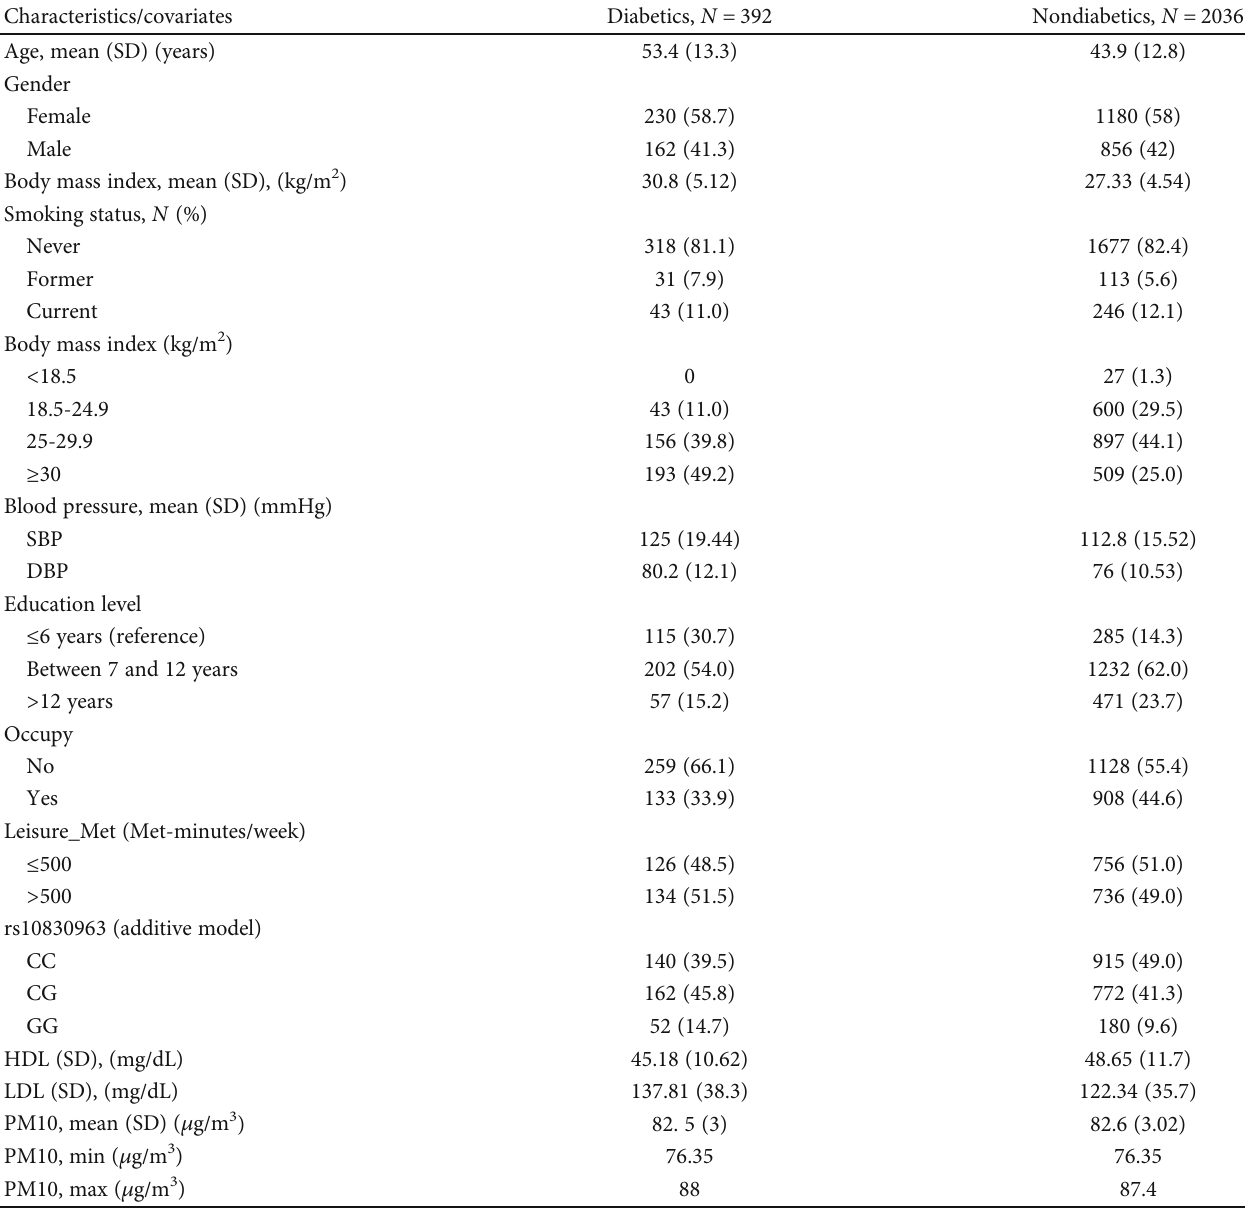
Table 2: Background characteristics of participants by diabetes